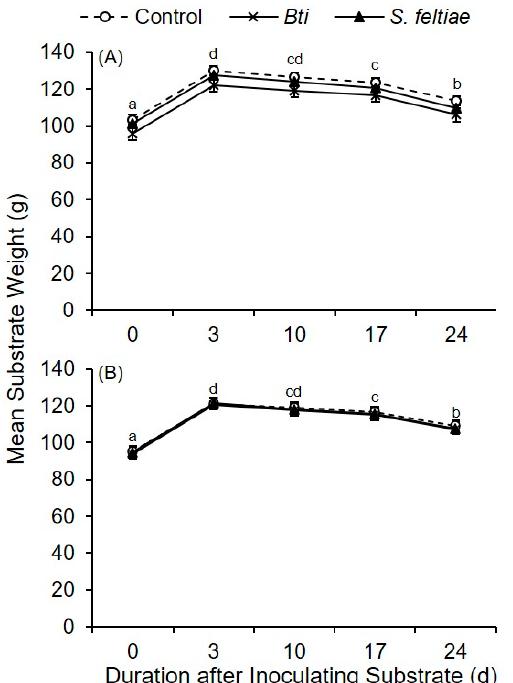
Figure 5. ( A , B ) Mean (±SE) weight of straw in bioassay containers inoculated with P. ostreatus and treated at 3 d post-inoculation with Bti , S. feltiae , or water as an untreated control. Significant differences were not detected in container weights among treatments over time (between-subjects, repeated measures ANOVA, α = 0.05), but significant within-treatment effects were detected over time (within-subjects, repeated measures ANOVA, α = 0.05). A significant difference was detected in substrate weights across the five time points when pooled among treatments; different letters indicate significant differences across the five time points within each bioassay (one-way ANOVA and LSD, α = 0.05).